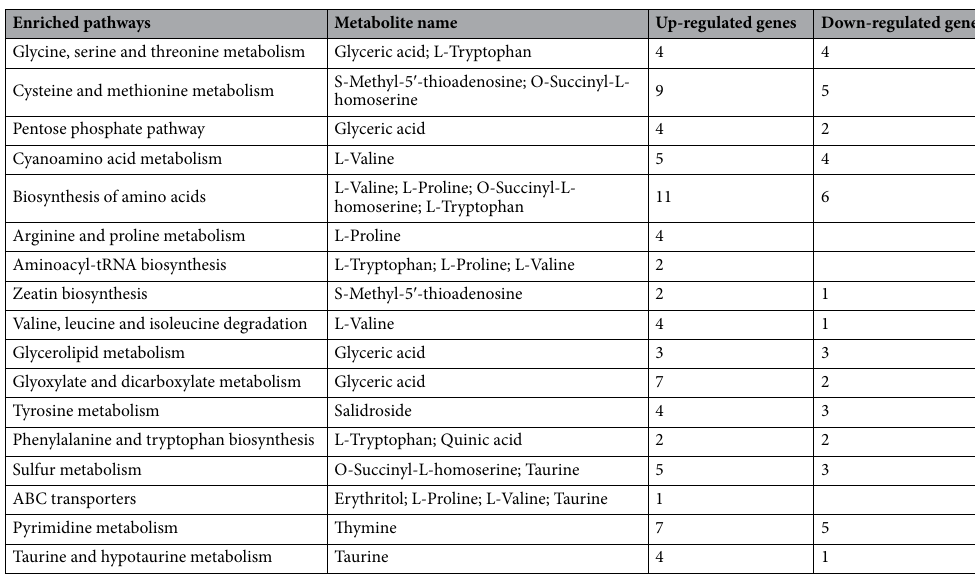
Table 1. The enriched pathways in the OE line under salt stress identified by Pearson correlation analysis of transcript and metabolite levels. Correlations with Pearson correlation coefficient > 0.80 and a Pearson correlation coefficient P value < 0.05 were considered